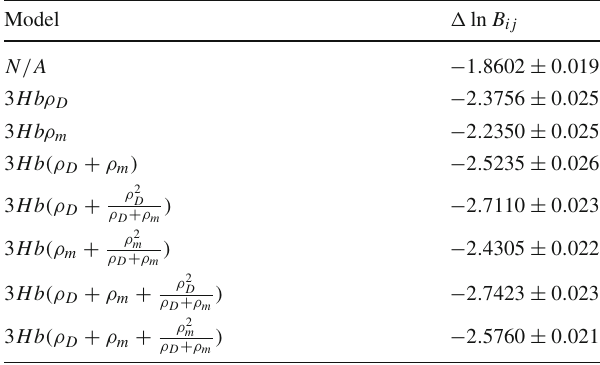
Table8 ThestrengthofJefrey’sscaleln B ij forholographicRIccidark energy model (EHRDE) compared to (cid:3) CDM model. The negative sign demonstrates that the (cid:3) CDM is superior to EHRDE model